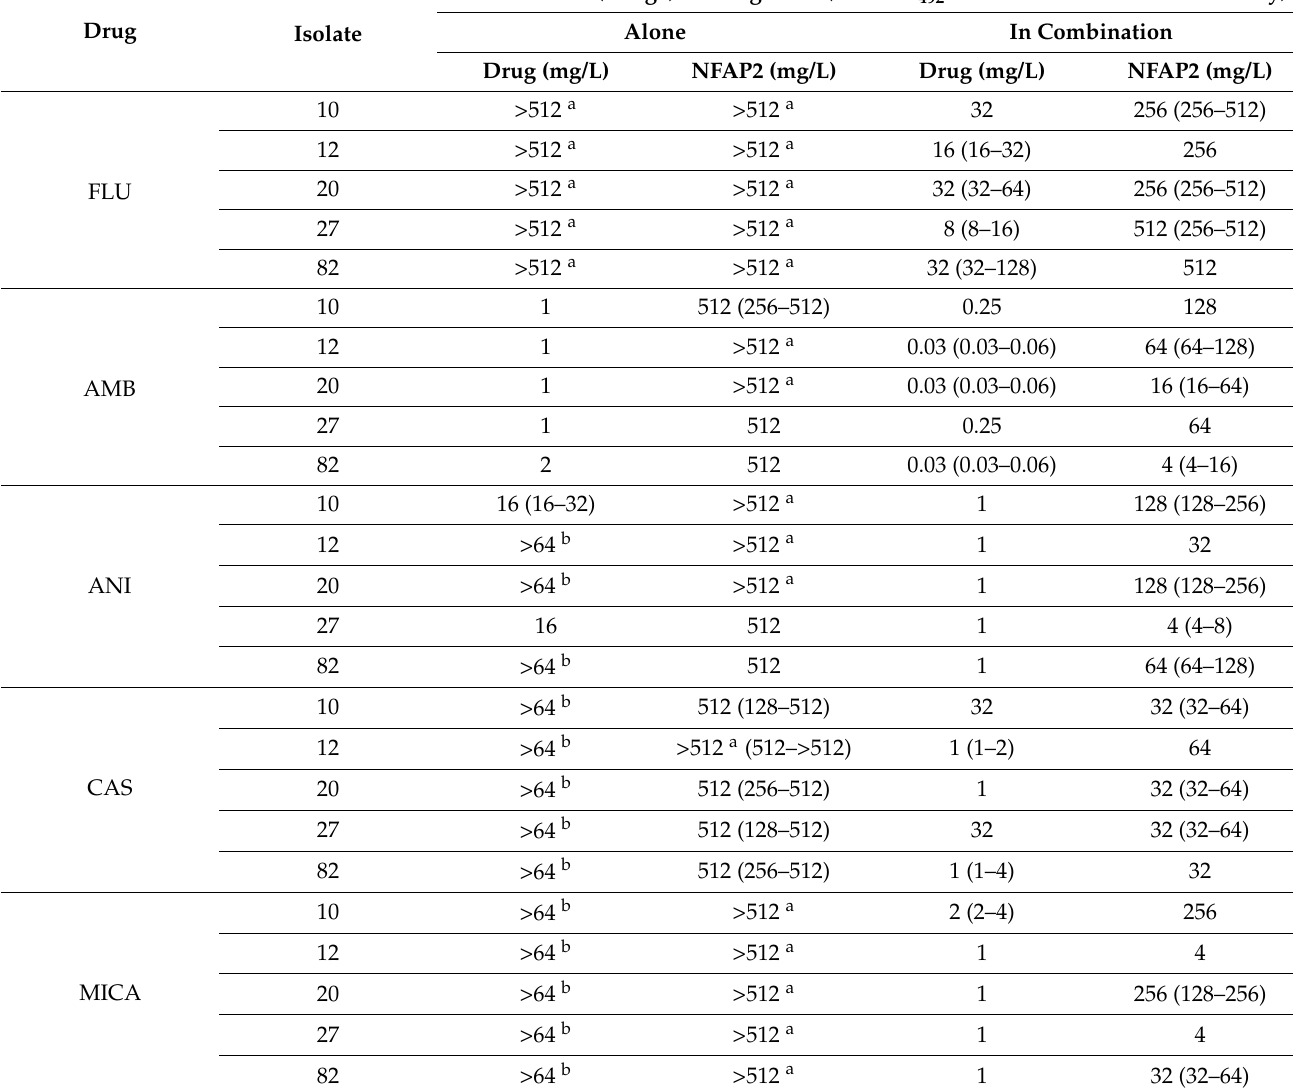
Table 1. Sessile minimum inhibitory concentrations (sMICs) of fluconazole (FLU), amphotericin B (AMB), anidulafungin (ANI), caspofungin (CAS) and micafungin (MICA) alone and in combination with NFAP2 against C. auris biofilms. Median MIC (Range) of Drug Used (50% OD 492 Reduction in Metabolic Activity) Drug Isolate Alone In Combination Drug (mg/L) NFAP2